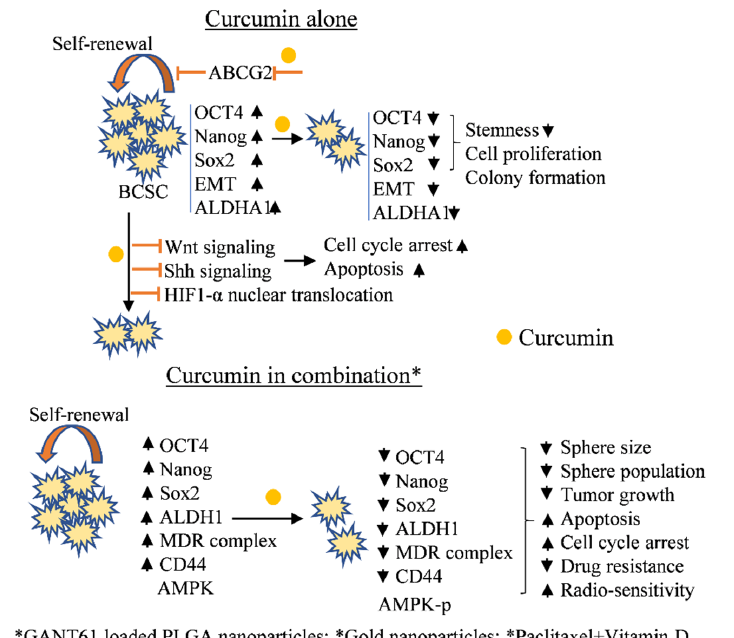
Figure 2. Effect of curcumin on luminal A-derived mammosphere. Yellow-colored circle represents curcumin. HIF-1 α —Hypoxia inducing factor-1 α , AMPK—AMP-activated protein kinase, EMT— Epithelial mesenchymal transition, Shh—Sonic hedgehog, ALDHA1—Aldehyde dehydrogenase A1, SRY (sex determining region Y)-box 2, and MDR—Multi-drug resistance.